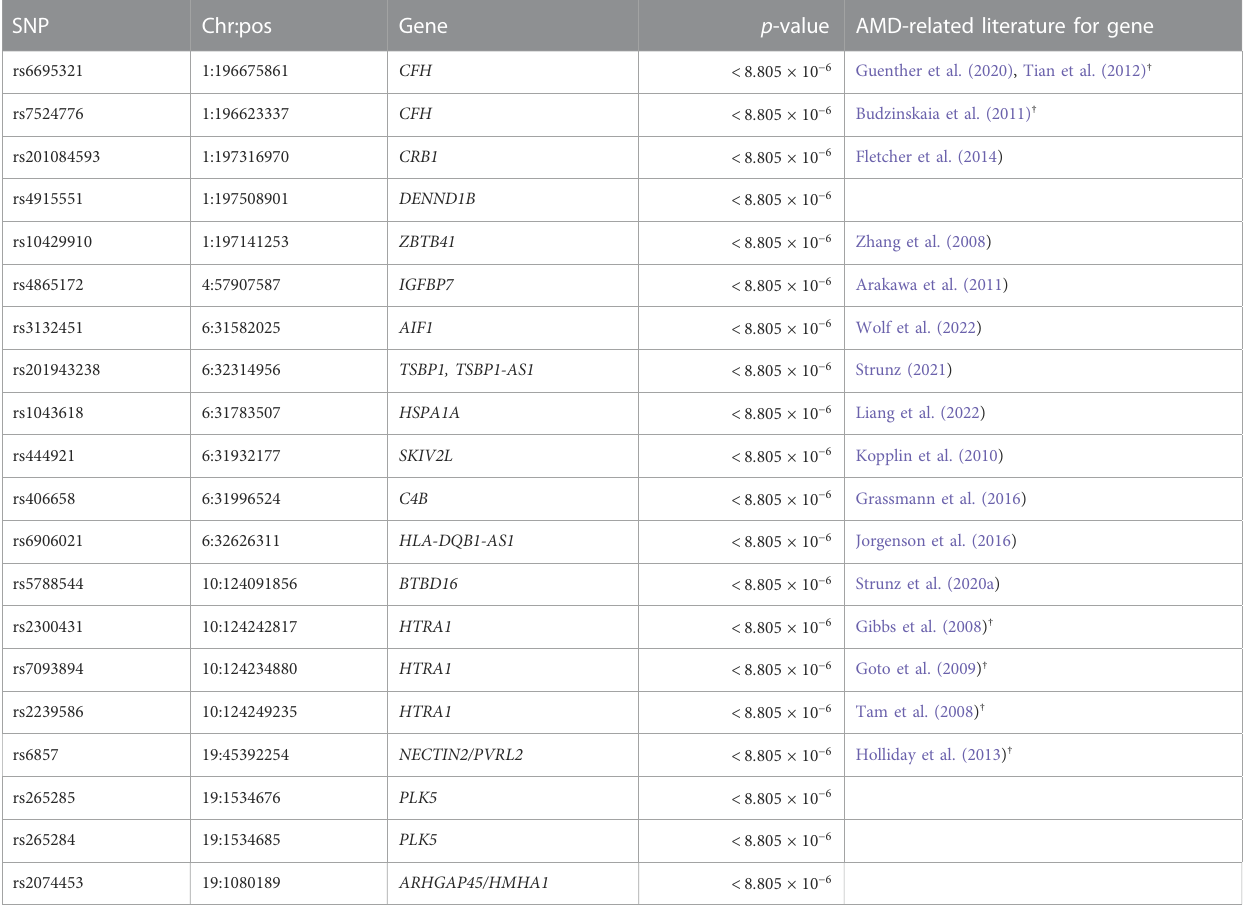
TABLE 1 Permutation p -values of selected marginally strong SNPs and their mapped genes. SNP Chr:pos Gene p